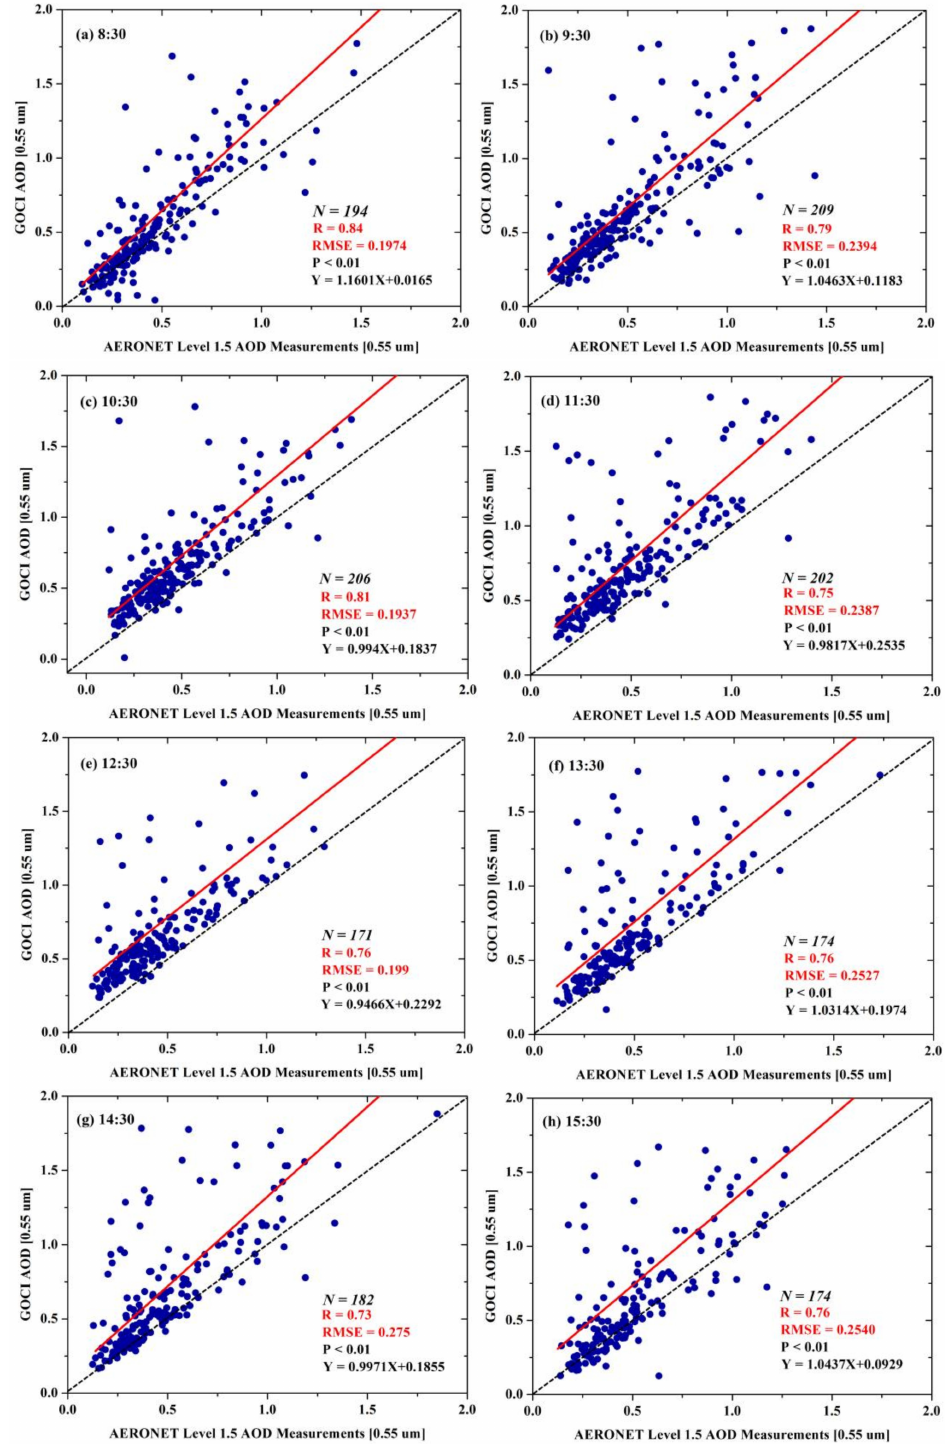
Figure 7. Comparison between AOD retrieved from GOCI images and Xuzhou-CUMT station measurements (The upper left corner indicates the sensor observation time, N is the number. ( a – h ) are the verification results of 8:30 a.m.–15:30 p.m., respectively). The AOD retrieved by satellite was compared with the observation data of Taihu and Xuzhou-CUMT stations, and the MAE and MRE of GOCI AOD at Taihu and Xuzhou- CUMT were calculated respectively (Figure 8). It can be seen that the AOD retrieved